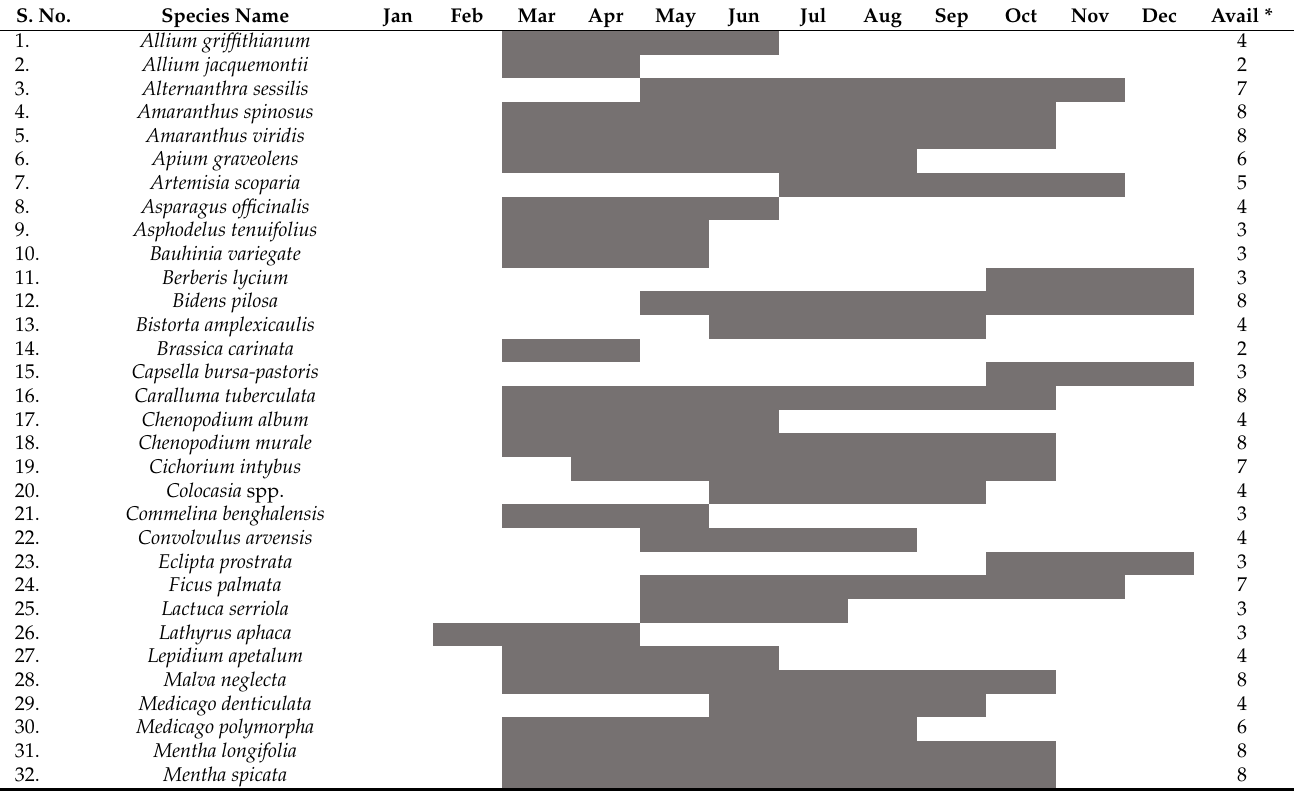
Table 4. Seasonal availability of wild vegetables in the Gadoon